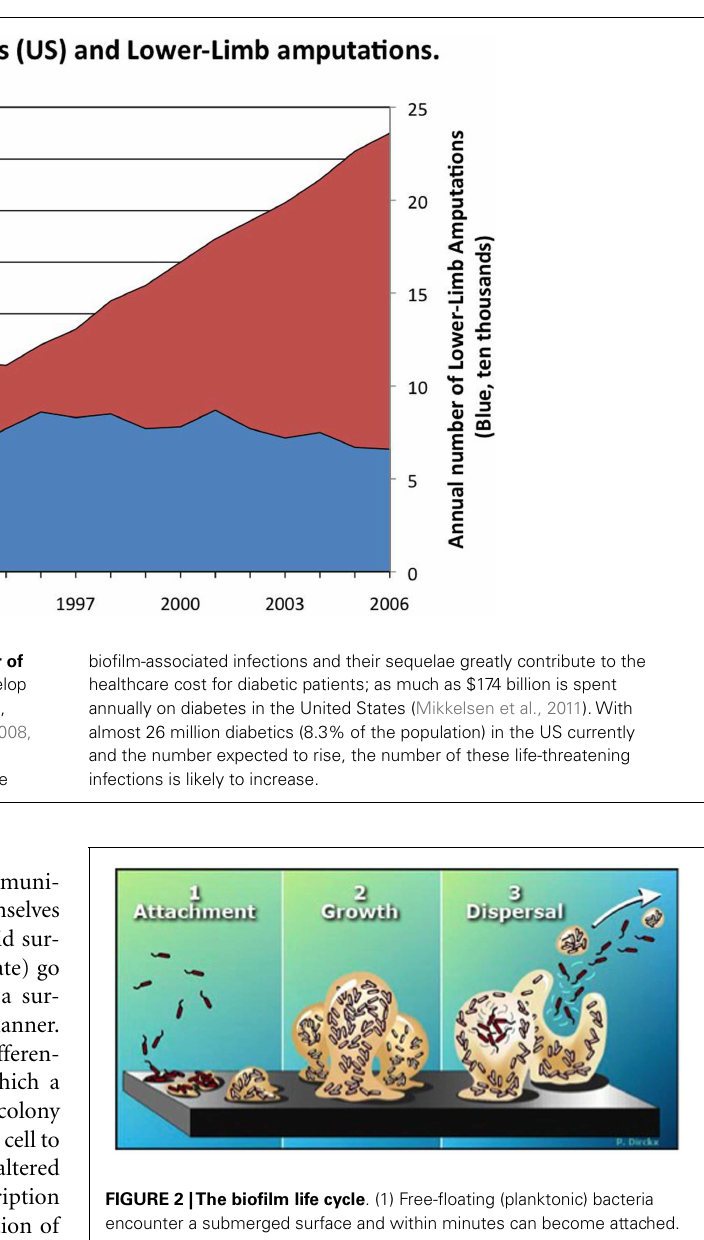
FIGURE 2 |The biofilm life cycle . (1) Free-floating (planktonic) bacteria encounter a submerged surface and within minutes can become attached. They begin to produce slimy extracellular polymeric substances (EPS) and start to colonize the surface. (2) EPS production allows the emerging biofilm community to develop a complex, three-dimensional structure that is influenced by a variety of environmental factors. Biofilm communities can develop within hours. (3) Biofilms can propagate through detachment of small or large clumps of cells, or by a type of “seeding dispersal” that releases individual cells. Either type of detachment allows bacteria to attach to a surface or to a biofilm downstream of the original community. [Biofilms:The Hypertextbook (http://www.hypertextbookshop.com/ biofilmbook/v004/r003/index.html). Used with permission from Montana State University Center for Biofilm